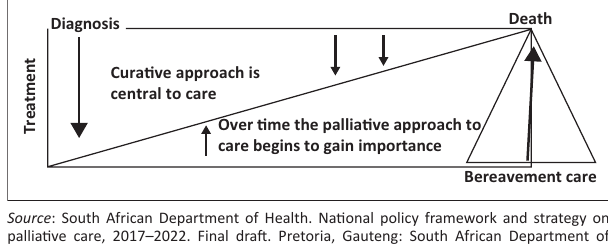
FIGURE 6: Current concept of palliative care: From diagnosis to bereavement. 1